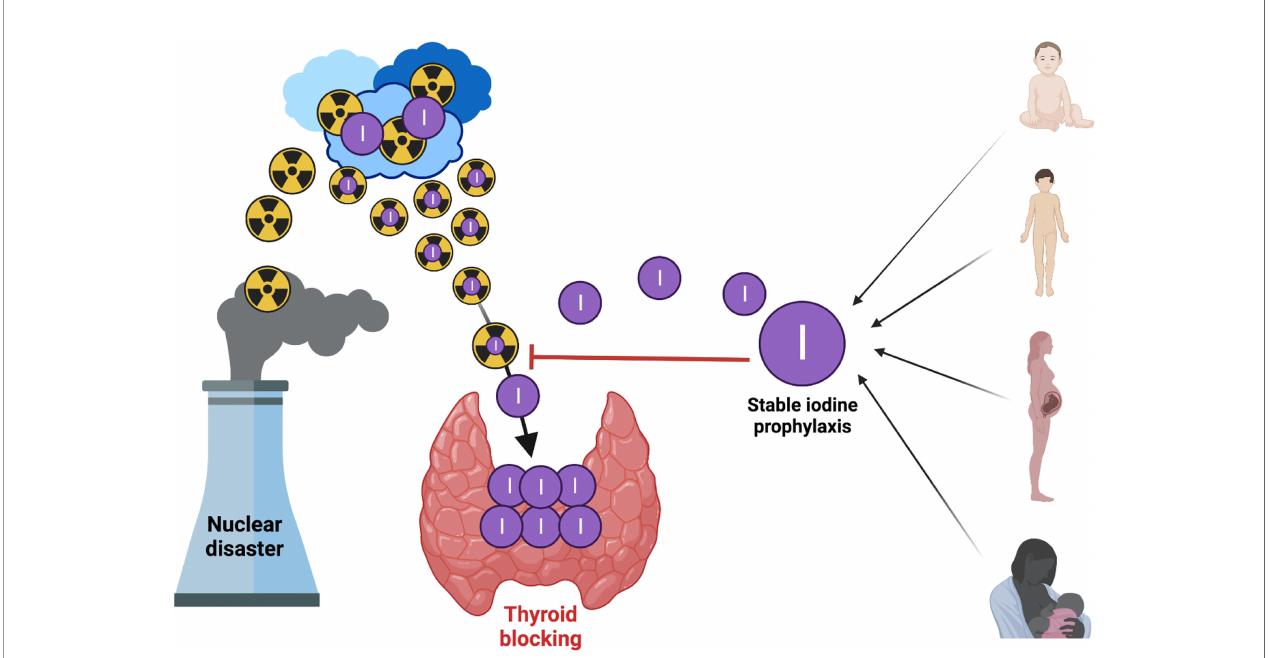
FIGURE 2 | Blocking thyroid with oral iodine to prevent uptake of radioactive iodine isotopes (created by using